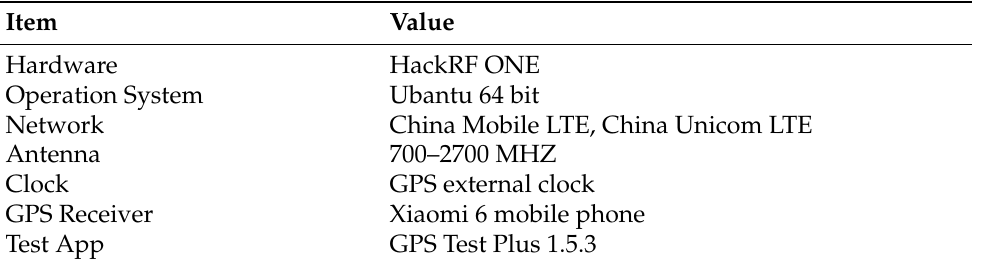
Figure 13. The test system of the hardware. Table 1. Experimental environment of GPS